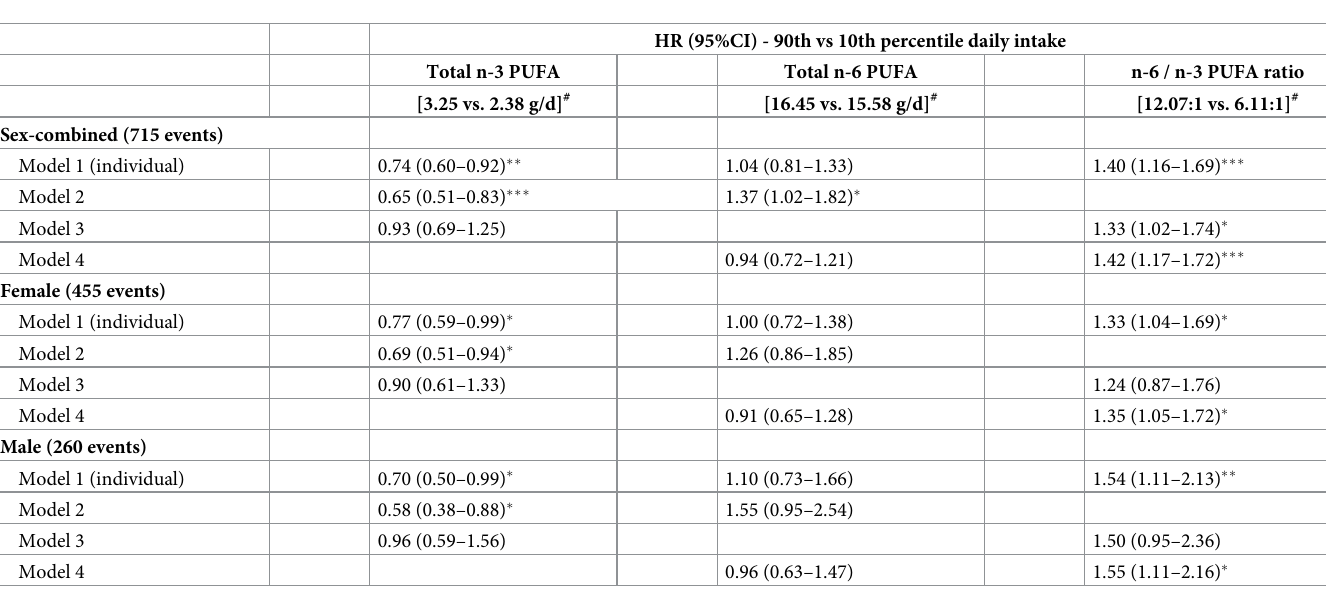
Table 2. Adjusted hazard ratios for total n-3 PUFA, total n-6 PUFA, and the n-6 / n-3 PUFA